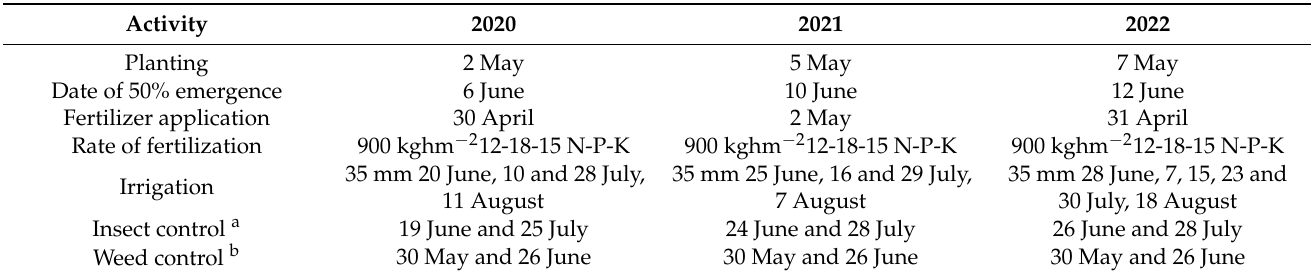
Table 6. Field operations and agronomic practices undertaken from 2020 to